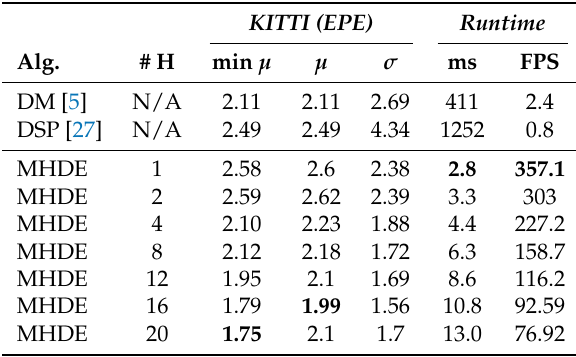
Table 1 details the comparative runtimes between DM, DSP, and MHDE with various numbers of hypotheses. MHDE runtime scales roughly linearly with number of hypotheses. Overall, the runtime gains of MHDE compared to DM show that providing a strong prior on camera motion allows for far more computationally efficient image predictions and matchings. Table 1. Benchmark results for our MHDE networks compared to DeepMatching (DM) [5], and DSP [27] on the KITTI [26] dataset for endpoint error (EPE) with 1–20 hypotheses (H). Mean results are presented from three networks for each condition for the MHDE networks. Min µ is the lowest mean EPE out of the three networks trained for each